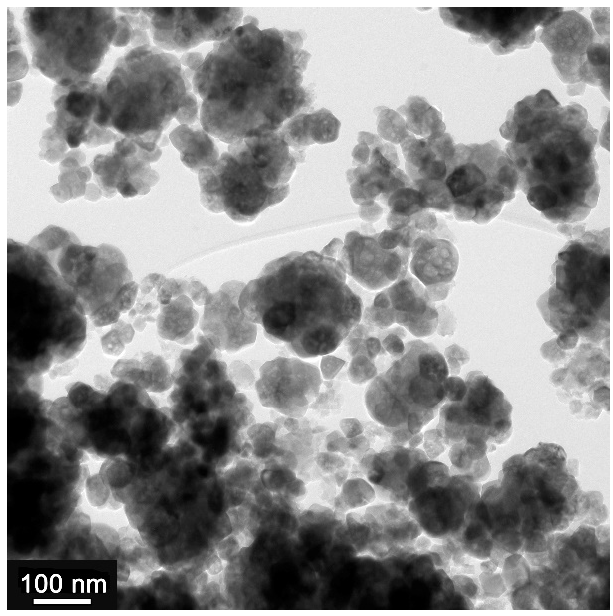
Figure 4. TEM image of Co 3 O 4 .